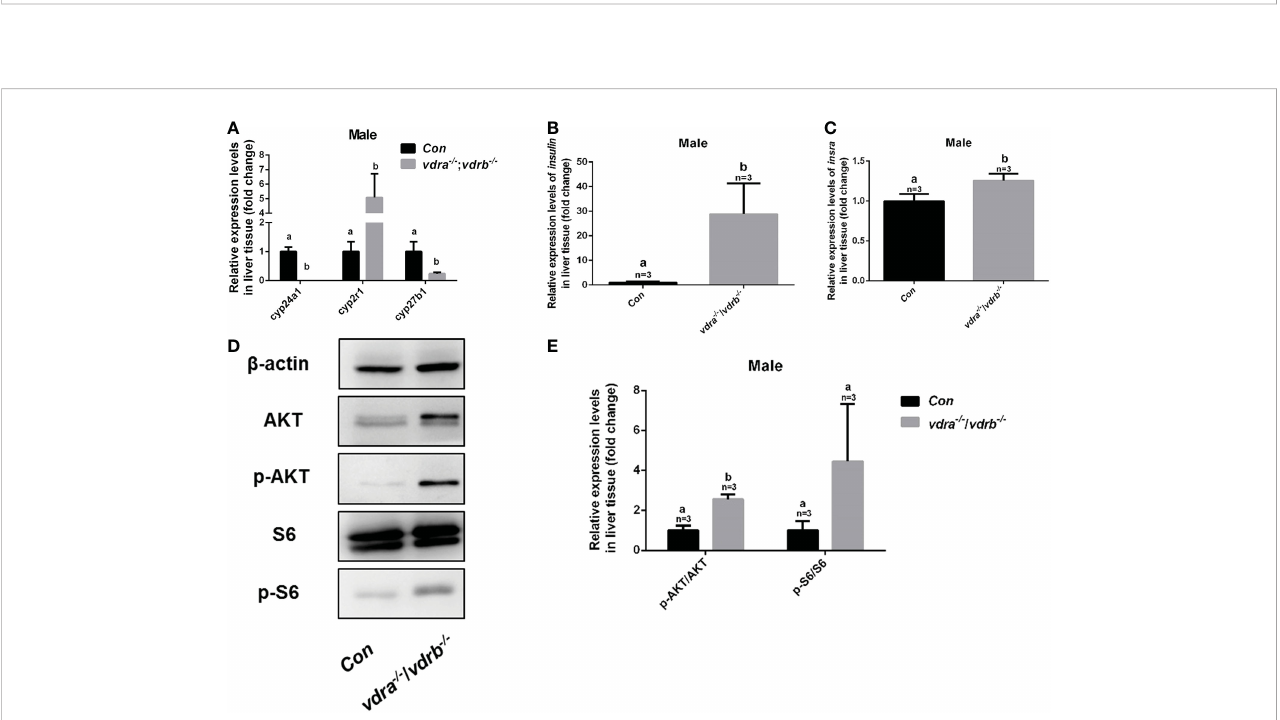
FIGURE 6 Enhanced insulin signaling observed in vdra -/- ; vdrb -/- zebra fi sh. (A) Quantitative real-time PCR showed the cyp24a1, cyp2r1 and cyp27b1 transcript levels in the liver of vdra -/ ;vdrb -/- fi sh and control siblings at 100 dpf; (B, C) Quantitative real-time PCR showed the insulin and insra , transcriptional levels in the liver of vdra -/ ;vdrb -/- fi sh and control siblings at 100 dpf; (D) AKT, p-AKT, S6, and p-S6 protein levels in liver samples of vdra -/- ;vdrb -/- fi sh and control siblings at 100 dpf; (E) Quanti fi cation of relative p-AKT/AKT and p-S6/S6 protein levels from western blot